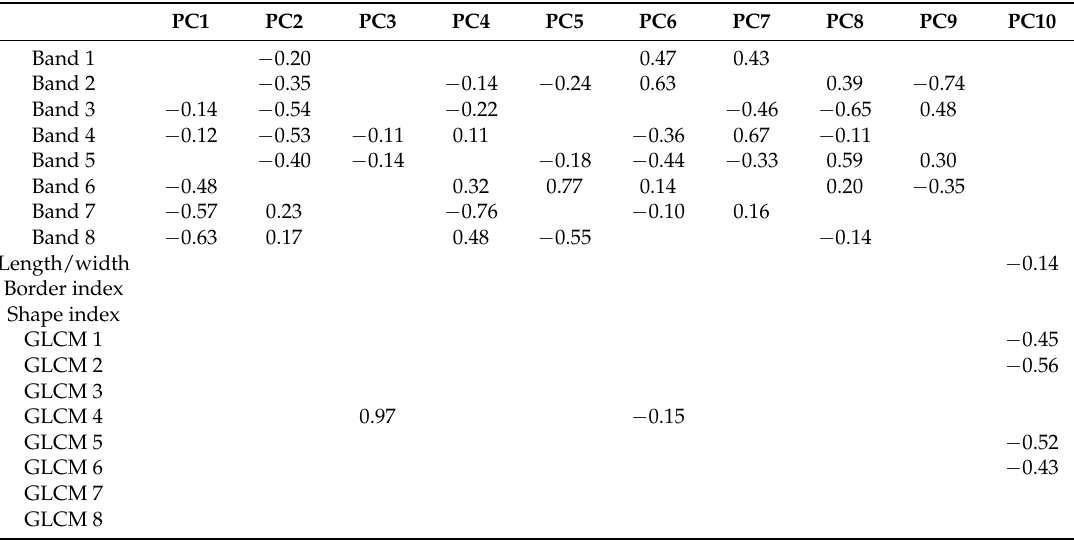
Table 2. Loadings of PCs (grey-level co-occurrence matrix (GLCM) Layers 1–8 represent the mean, standard deviation, homogeneity, contrast, dissimilarity, entropy, correlation and angular second moment,